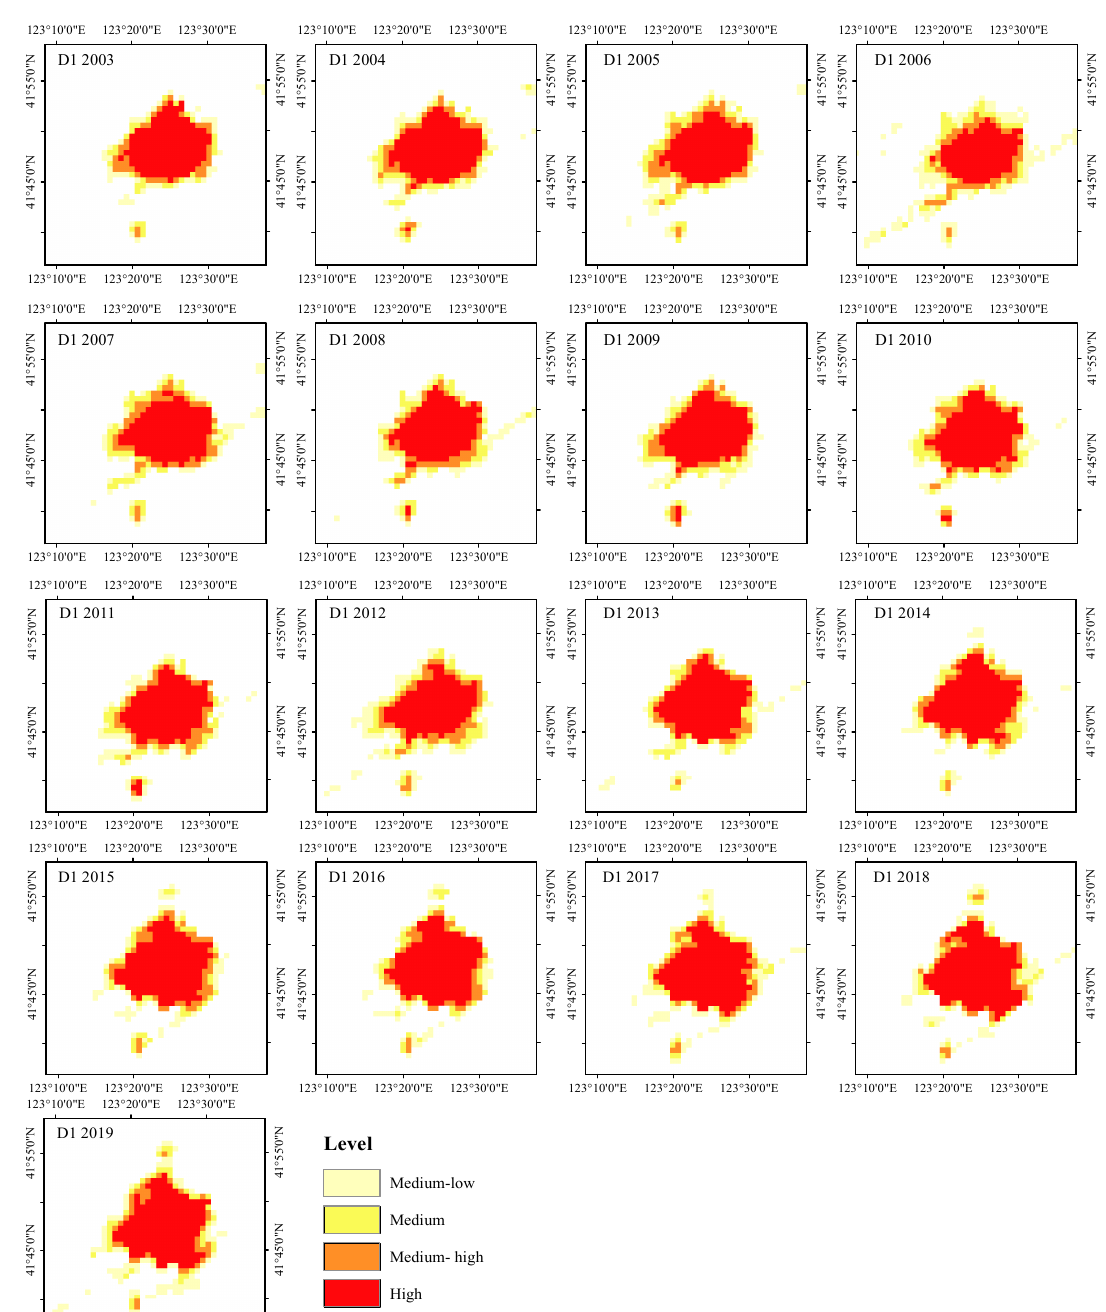
Figure 7. Equivalent heat island area (EHIA) from 2003 to 2019. The variations in the equivalent heat island intensity are shown in Figures 8–10. For the three study areas, the urban core area is in a high EHII. It is observed that the high EHII in the D1 area expands to the south, and the high EHII in the D2 area expands to the east. The existing research on D1 and D2 has shown that the urban center of the D1 area has moved southward, and the urban center of gravity of the D2 area has moved eastward [77]. The newly added equivalent heat island area in the northern part of the D3 area has reflected the impact of the new area built by the city. Therefore, the observed phenomenon based on the equivalent heat island intensity is consistent with the changes in the city.